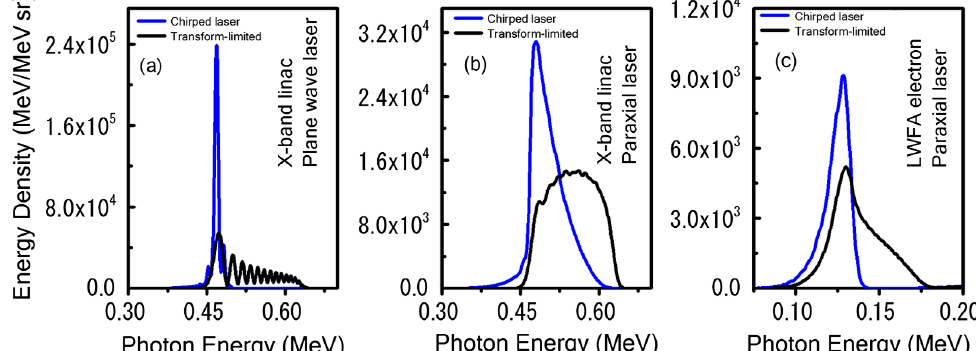
FIG. 9. Scattered on-axis energy density per electron from the interaction of an x -band linac electron beam with a 90-fs FWHM and 1 : 6 (cid:3) 10 18 - W = cm 2 -peak-intensity transform-limited (black line) and chirped laser (blue line) under the plane wave approximation (a) and a TEM 00 spatial mode with Gaussian profile (b). The scattered on-axis energy density from a LWFA electron beam using a Gaussian transform-limited laser focus (black line) and chirped laser focus is shown in (c). The FWHM beam sizes of the laser focus and the LWFA electron beam are 14 and 2 (cid:3) m ,